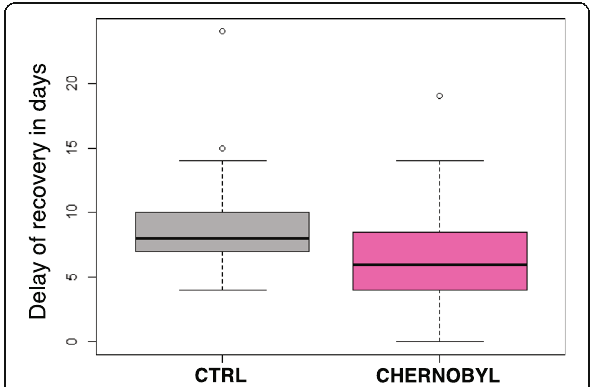
Fig. 1 Chernobyl bank vole fibroblasts recover faster after irradiation than control cell lines. The fibroblast cell lines isolated from Chernobyl bank voles (pink) were able to reach 100% confluency, on average, 2 days faster than the control cell lines (grey) after 10 Gy irradiation. “ The delay of recovery ” represents how many days longer an irradiated cell line took to cover the plate than the corresponding non-irradiated cell line. The figure shows results from three separate experiments using eight Chernobyl ( N = 24) and eight control ( N = 24) cell lines. In the box blot the box presents the lower and upper quartiles, median is indicated by a line, whiskers show values within 1.5 interquartile range from the boxed values, and circles are outliers (R version